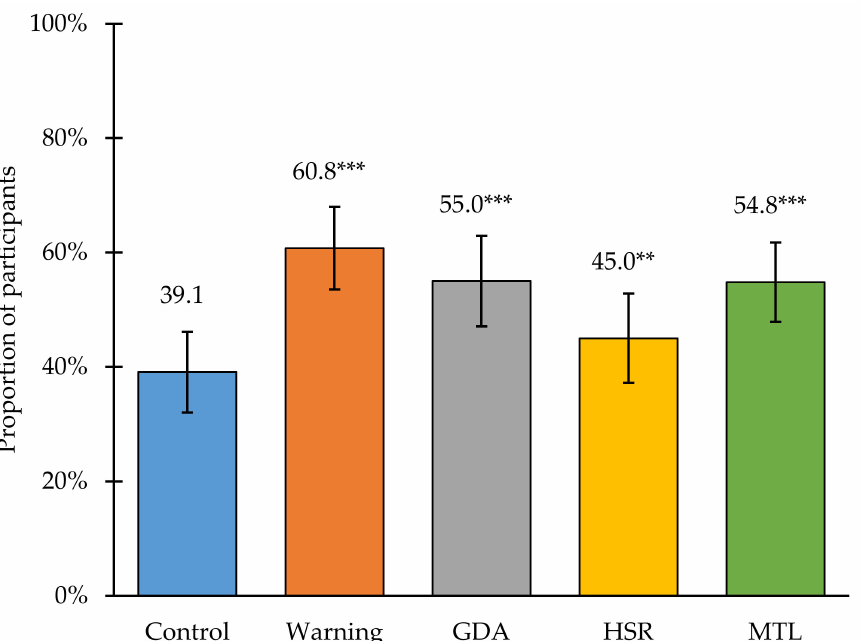
Figure 2. Percent of participants who correctly identified that products were high in nutrient(s) of concern by study arm. *** p -Value < 0.001 relative to the control label; ** p -Value < 0.01; GDA— Guideline Daily Amount, HSR—Health Star Rating, MTL—Multiple Traffic Light Label.